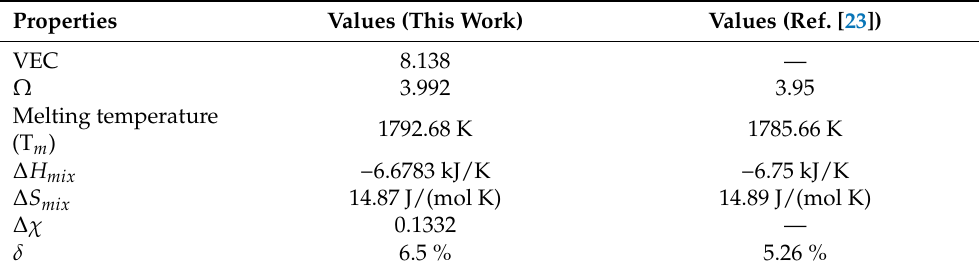
Table 1. Tabulation of the values of the properties—VEC, Ω , T m , ∆ H mix , ∆ S mix , ∆ χ and δ of Ti 0.8 CoCrFeNiCu HEA, computed using the Automatic Featurizer library in this present work. It is to be noted that the melting temperature (T m ) property of the HEA is being used in the computation of the Ω property feature, and thus, T m data will not be considered as a separate feature in the ANN of this present work. In this table, the values of Ω , T m , ∆ H mix , ∆ S mix , and δ for the HEA calculated in this work are compared with the corresponding values presented in Yang and Zhang